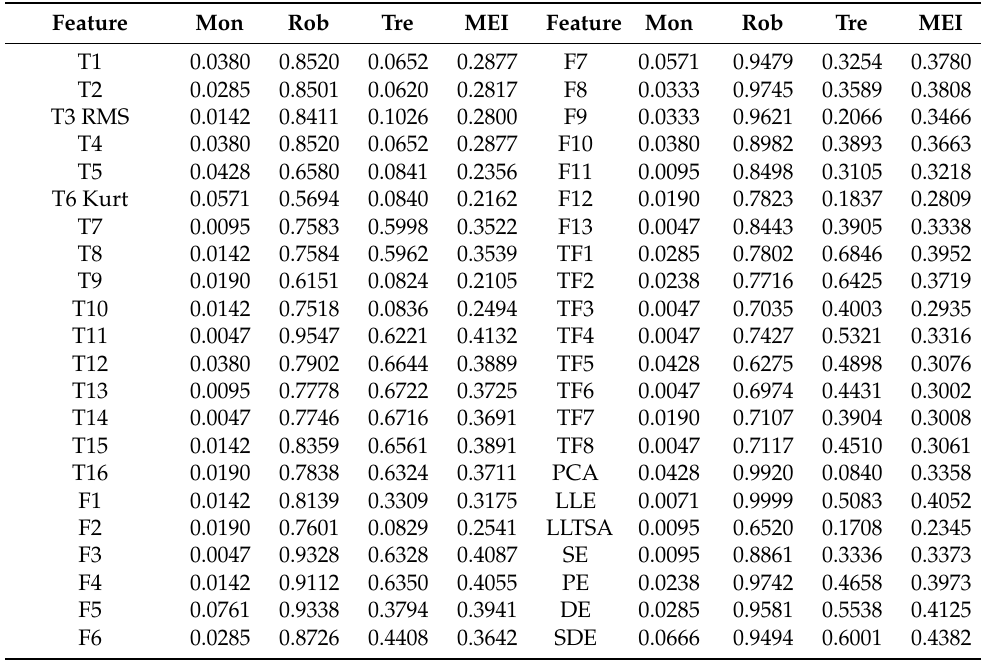
Table 2. The evaluation results of check valve fault state